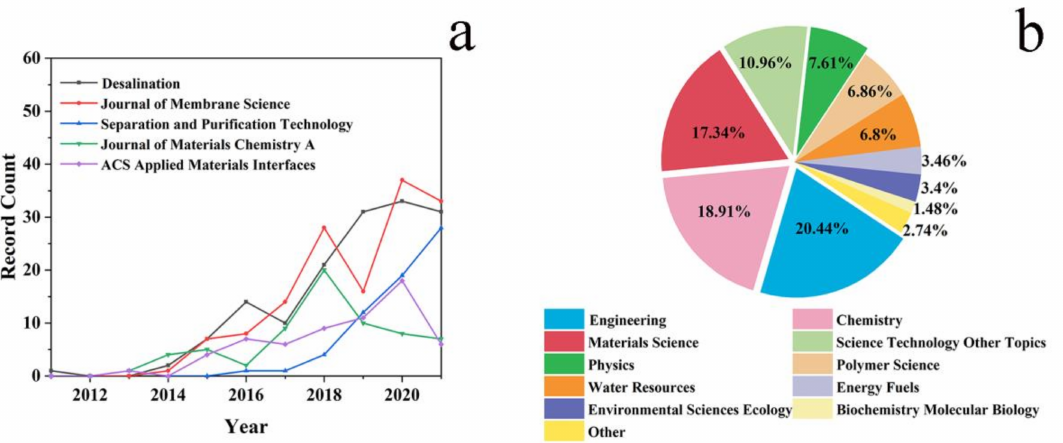
Figure 4. ( a ) Publications by year by top publication journals; ( b ) publications by subject